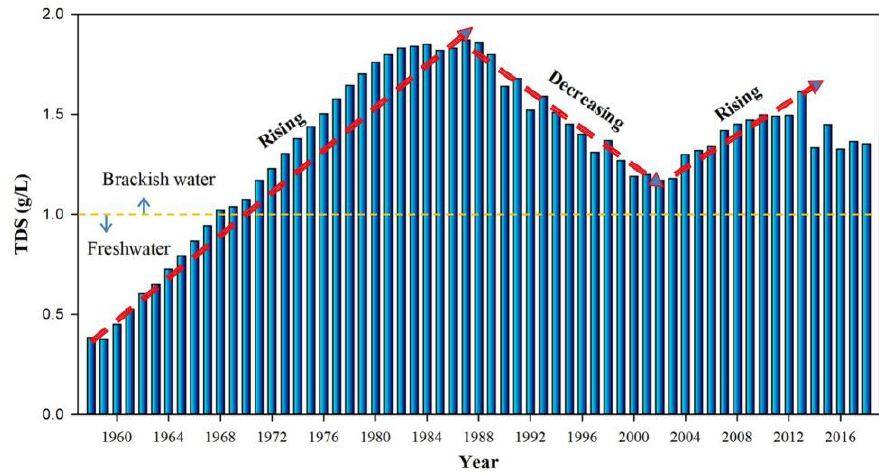
Figure 2. Annual average TDS content of Bosten Lake in 1958 – 2018. (Red arrow line is a trend line; Yellow line is the critical line of brackish water and fresh water).